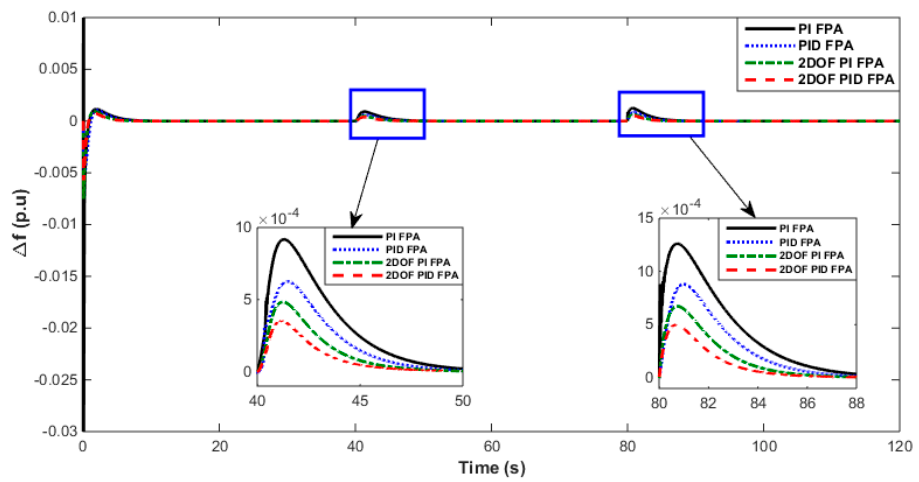
Figure 8. Comparative changes in the frequency deviations observed with the FPA-tuned PI, PID, 2DOF PI, and 2DOF PID controllers in case 2.